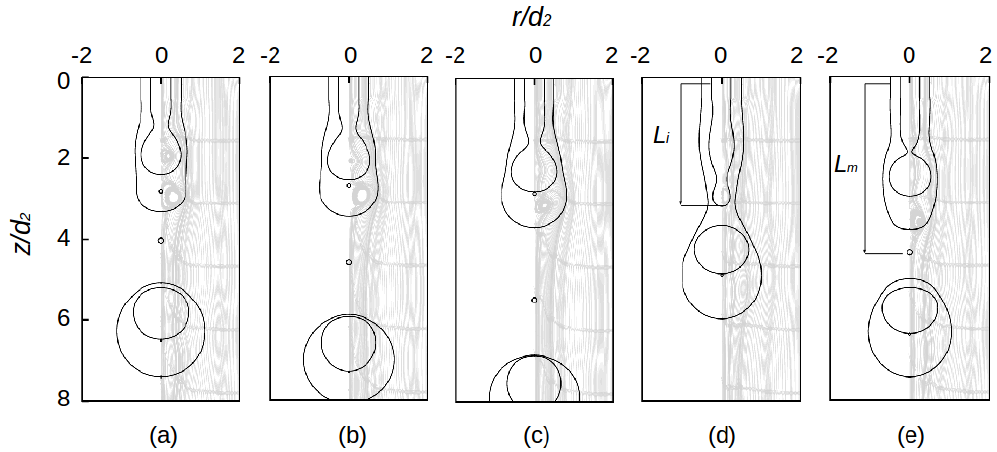
Figure 4. Snapshots of phase boundaries of compound liquid jets for ρ 13 = 1, ρ 23 = 1, µ 13 = 1, µ 23 = 1, with the rest of the parameters as Re = 37.5 and We = 1.5, with streamlines superposed in the right halves at non-dimensional times of: ( a ) τ = 23.68; ( b ) τ = 24.08; ( c ) τ = 24.56; ( d ) τ = 27.04 and ( e ) τ = 28.08. Readers can refer to Video “S1:Baseline case” in the Supplementary Materials for better understanding of the breakup process of the baseline